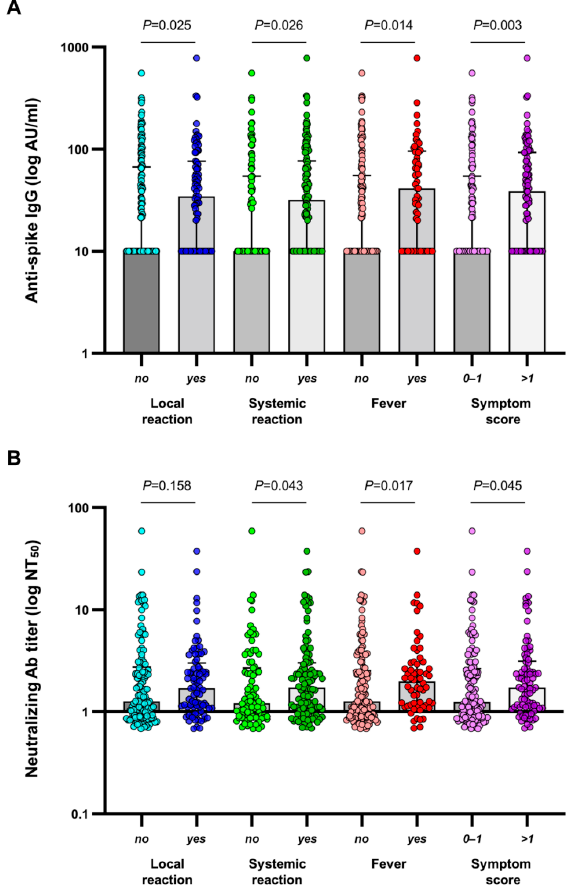
Figure 3. ( A ) SARS-CoV-2 anti-spike IgG antibody concentrations and ( B ) SARS-CoV-2 neutralizing antibody titers at 28 days following the first dose of ChAdOx1 nCoV-19 according to the absence or presence of reactogenicity. The median and interquartile range are shown. IgG values below the lower limit of quantitation were set to 0.5 times the lower limit of quantitation. AU, arbitrary units.